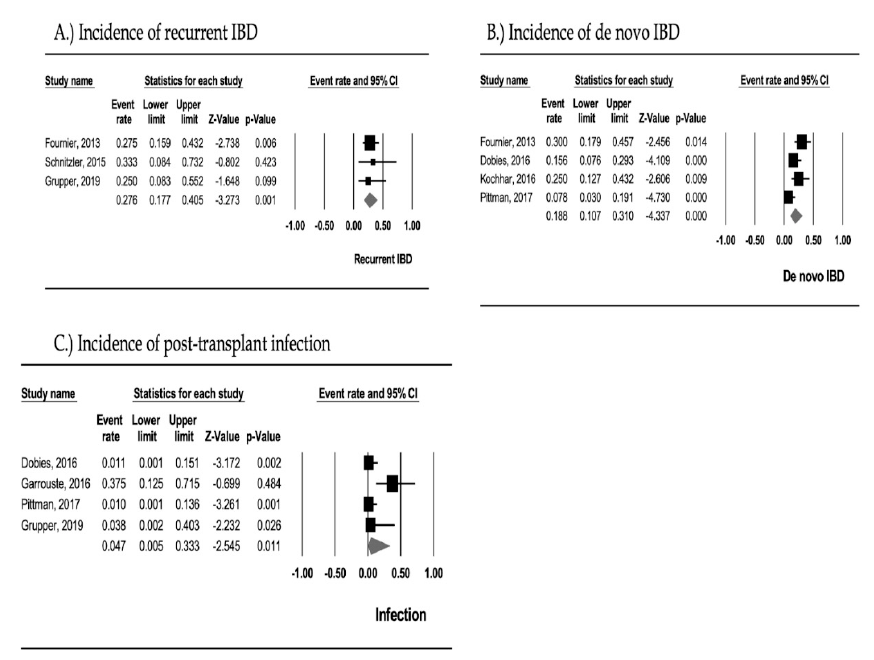
Figure 1. Preferred Reporting Items for Systematic Reviews and Meta-analysis (PRISMA) flowchart of article search and selection.